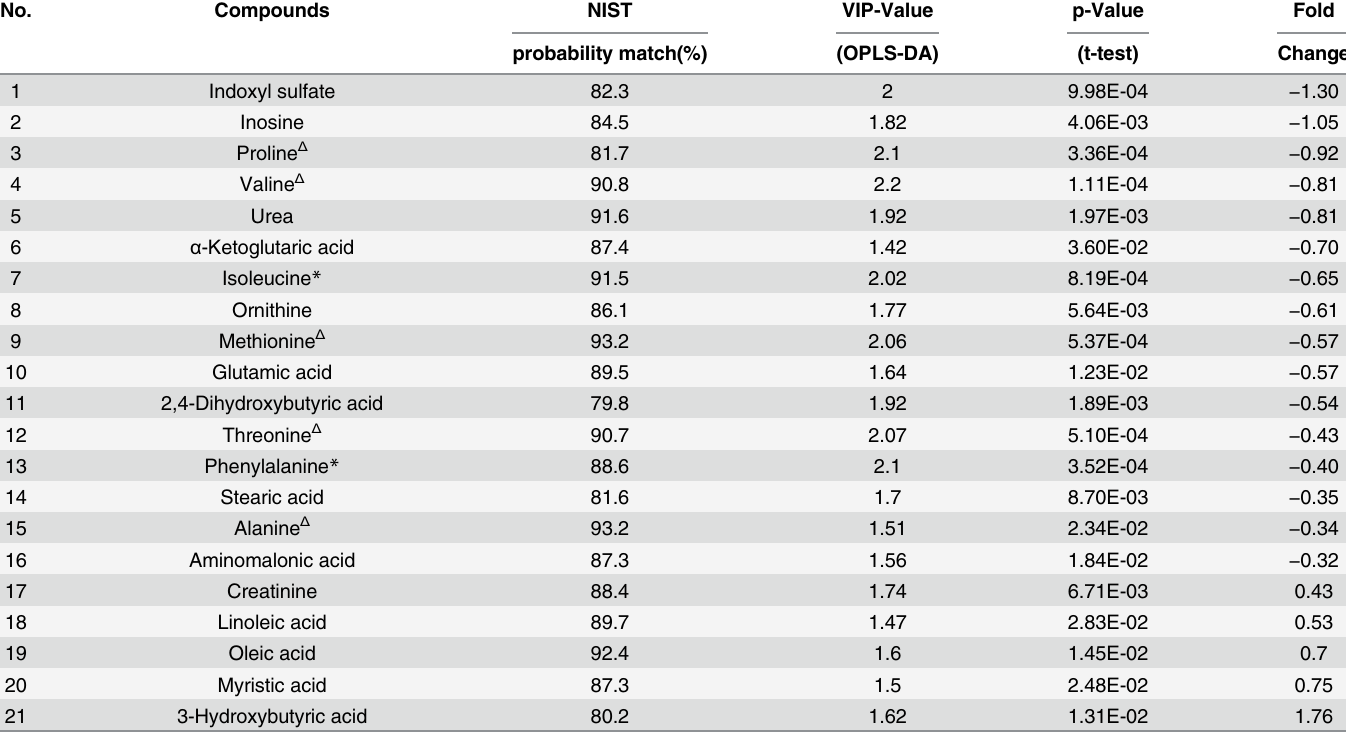
Table 2. The differential metabolites in the plasma between G6PDx-FB and G6PDx control mice.